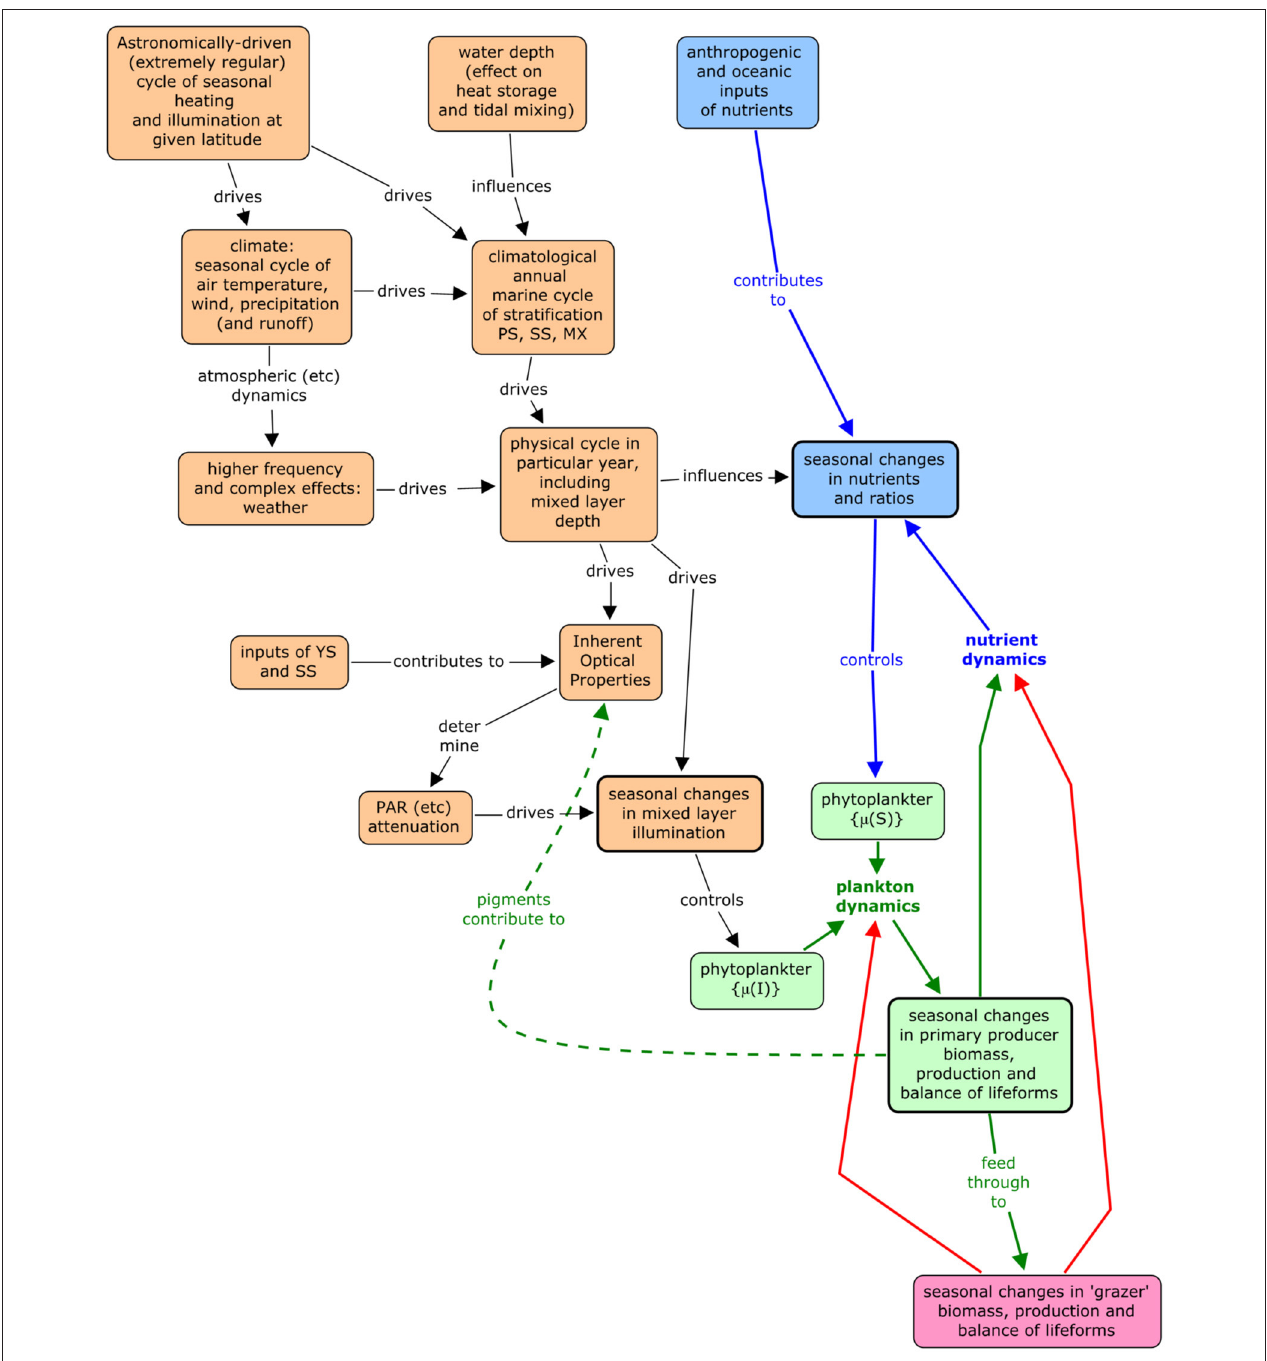
FIGURE 1 | Conceptual model of the relationship between abiotic processes and pelagic ecosystem vigor and organization.